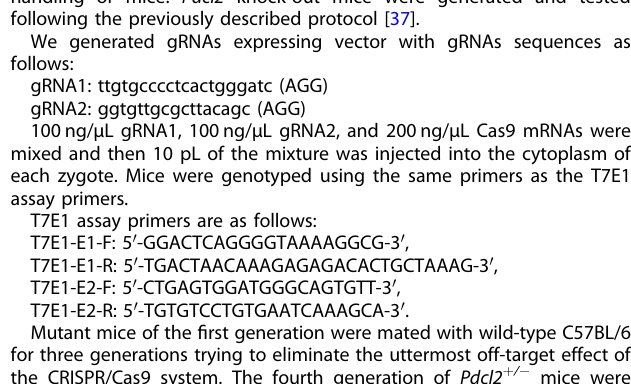
Fig. 3 Pdcl2 is required for spermiogenesis and fertility of male mice. A Body weight of 11-week-old male mice. B Fertility test. Pdcl2 + / + , Pdcl2 + / − , and Pdcl2 − / − males were mated with wild-type C57BL/6 female mice for one month period of continuous mating. Six adult male mice of each genotype were used. Pdcl2 − / − males gave birth to no pups. C , F Appearance of testis or epididymis. Bar, 1 cm. D , G Reduced testis and epididymis weight of Pdcl2 − / − mice. The tissue to body ratio was used to normalize the data. Each sample dot represents the average parameter of both sides of testis or epididymis from the same mouse. E , H Hematoxylin and eosin stained cross sections of paraf fi n- embedded mouse testis or cauda epididymis. Bar, 100 µm. E Stage XI seminiferous tubule cross section was shown. Less elongated spermatids could be found in Pdcl2 − / − mice. H Round shaped cells instead of elongated spermatids could be observed in the epididymis of Pdcl2 − / − mice. I , J Apoptosis analysis of mouse testis or cauda epididymis section. TUNEL positive signals were counted from pictures of the stained sections. The pictures were taken at random places of the specimens. Each picture covered an area of 375,240 µm 2 . Each dot of the diagram represented a count number of one picture. Different color of dots represented datasets from different specimens. Lines with different color represented means of the datasets. Lines in black represented means of the three means of each group. K Percentage of germ cells with different ploidy type in testes of 11-week-old male mice. More than 10 4 cells of each sample were gated. Data of this fi gure were represented as mean ± standard deviation. *, p < 0.05; **, p < 0.01; ***, p < 0.001. n , mouse